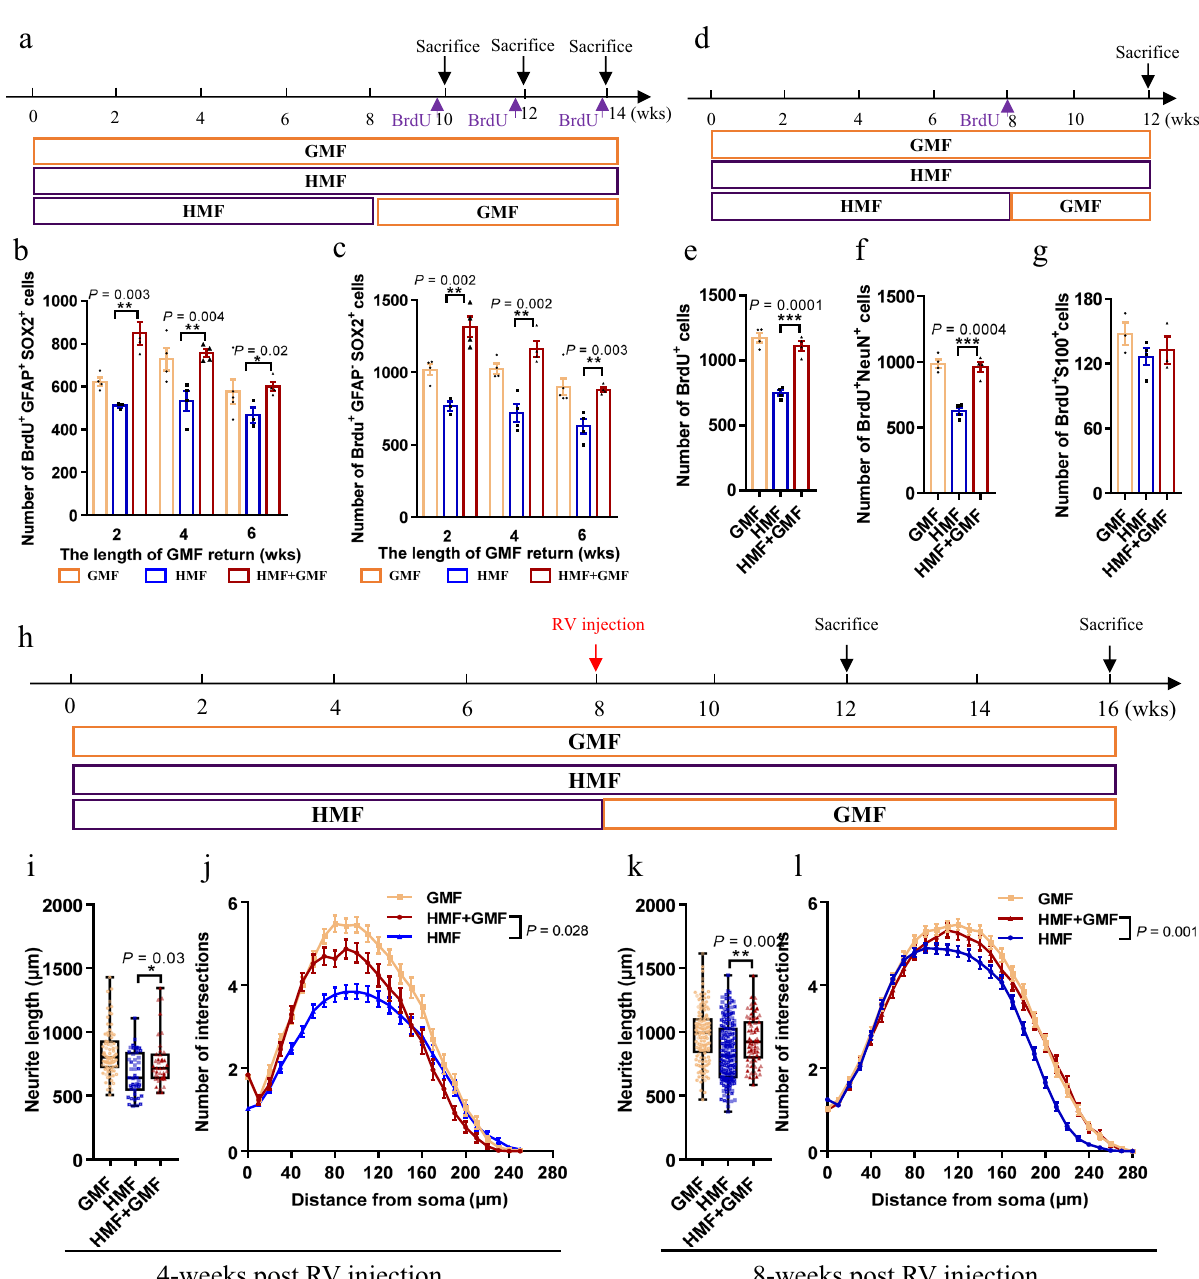
Fig. 6 Return to GMF rescued the defective adult hippocampal neurogenesis of HMF-exposed mice. a Experiments timeline for cell proliferation analysis in HMF-exposed mice, followed by 2-, 4-, 6-weeks return to GMF. b , c Quanti fi cation of numbers of BrdU + Sox2 + GFAP + cells ( b ) and BrdU + Sox2 + GFAP